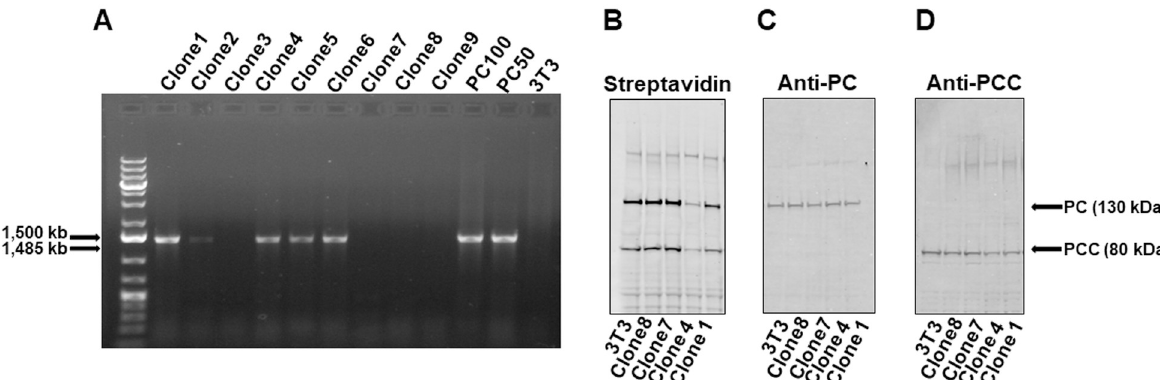
Fig 2. Functionality of HLCS KO in NIH 3T3 mouse fibroblasts. (A) Transformation of cells. Clones were identified by PCR amplification of FloxP-FRT. 3T3 cells transfected with 100 or 50 μ g/250 μ L of HLCS KO vector before clonal selection; were used as positive controls; wild-type mouse 3T3 embryonic fibroblasts were used as negative control. (B) Carboxylase biotinylation in transformed cells. Biotinylated carboxylases were probed by using streptavidin. (C) Pyruvate carboxylase (PC) in was probed with anti-pyruvate carboxylase. (D) Propionyl-CoA carboxylase (PCC) in was probed with anti- propionyl-CoA carboxylase.